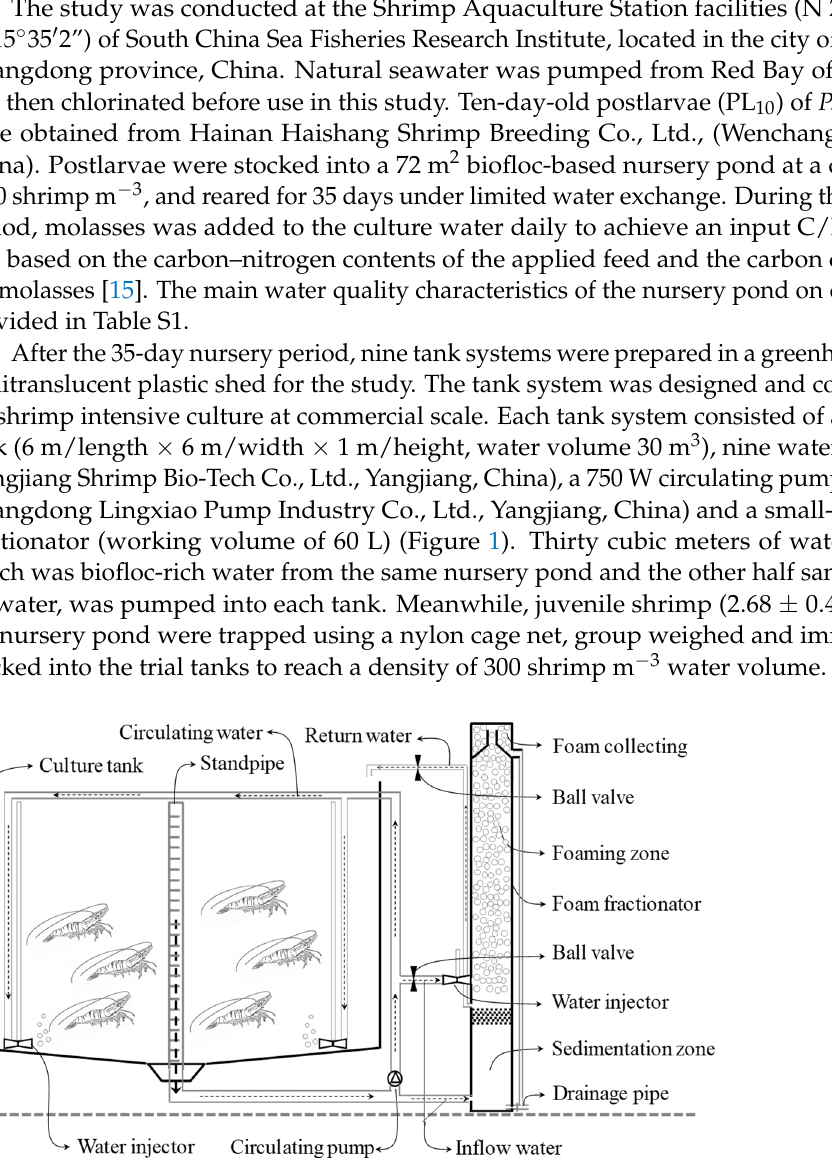
Figure 1. Schematic diagram of a commercial biofloc technology system with zero-water exchange for shrimp intensive production. Arrows indicate water flow. Water was pumped from the culture tank by running the circulating pump; most of water circulated to the culture tank through water injectors. The remaining water flowed into a foam fractionator and then returned to the culture tank. The water entering and leaving the foam fractionator was adjusted by ball valves at water flow rates of 15~25 L min − 1